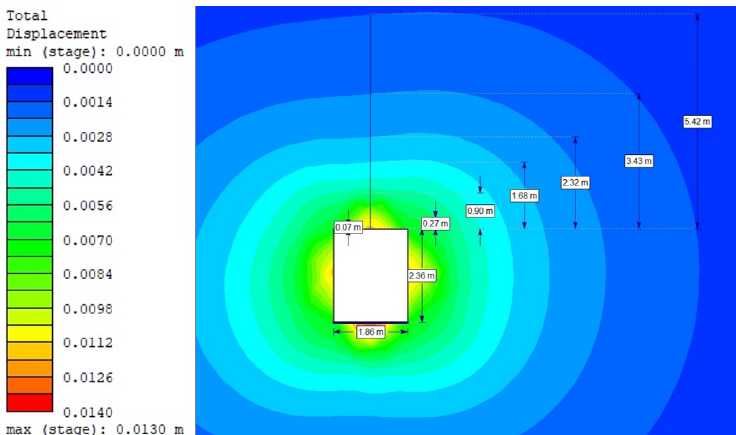
Figure 6. Total strain for Vernier excavation without bolting (Hoek–Brown